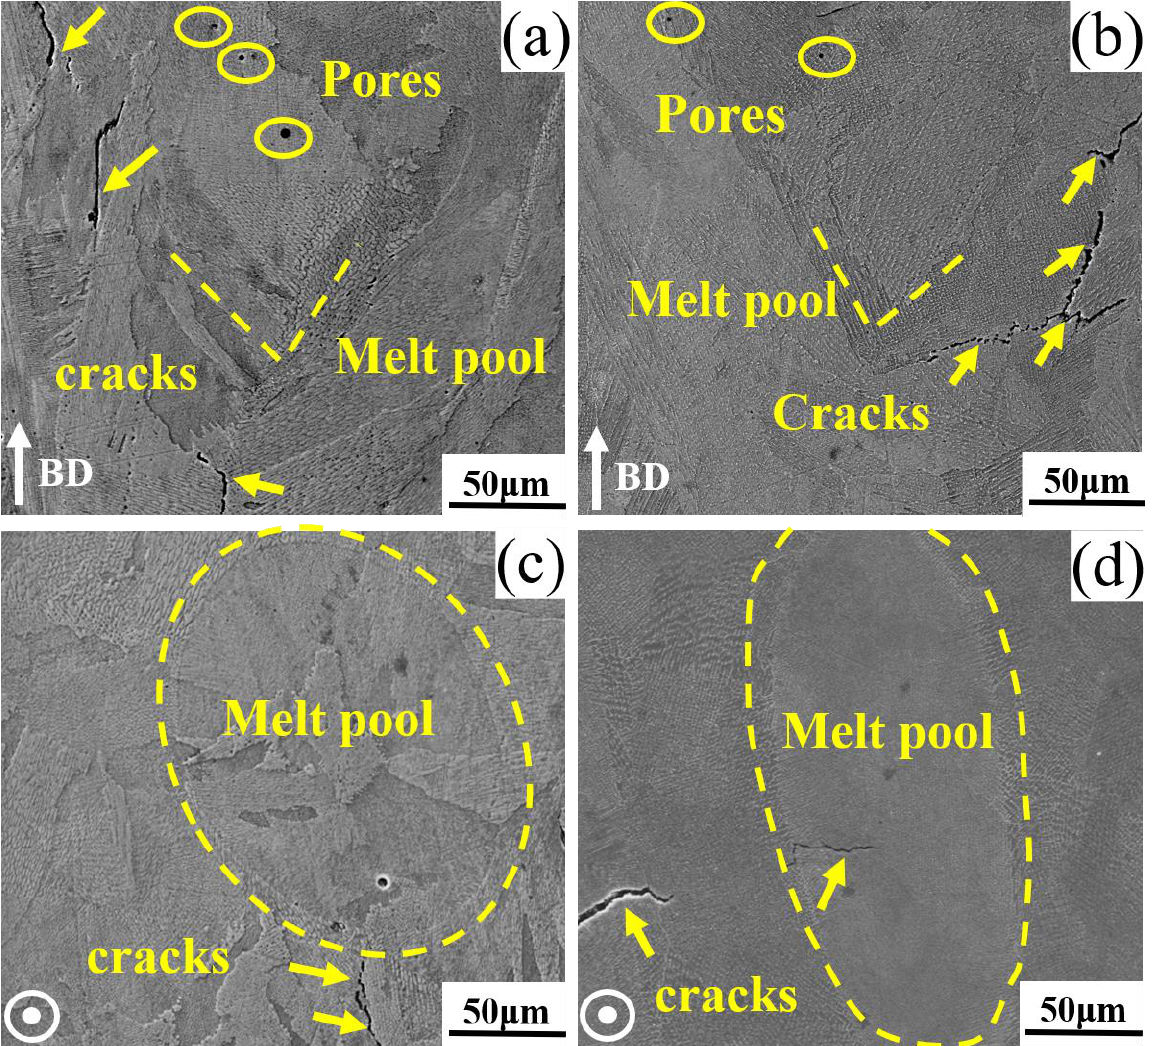
Figure 2. BSE images of as-printed microstructures in ( a ) the XZ plane in 13Co, ( b ) the XZ plane in 35Co, ( c ) the XY plane in 13Co, and ( d ) the XY plane in 35Co. The XZ plane was parallel to the building direction, and the XY plane was perpendicular to the building direction.